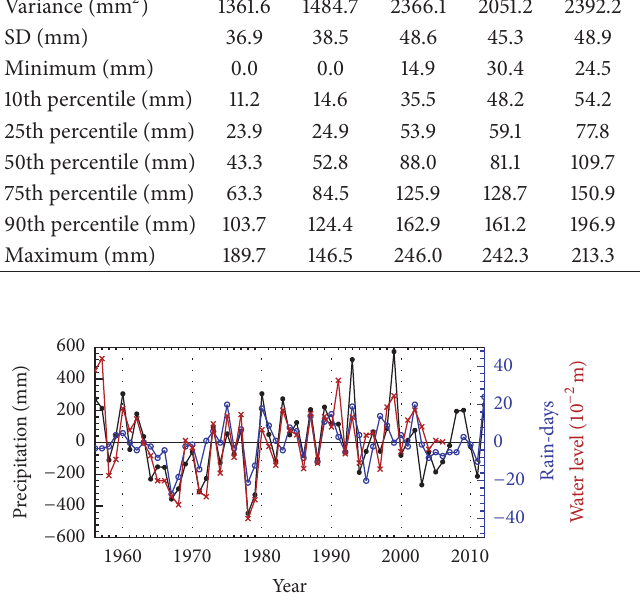
Figure 5: Relationship among the anomalies of annual rainfall (black solid circle), annual rain-days (blue open circle), and annual water level of Taihu Lake (red ×